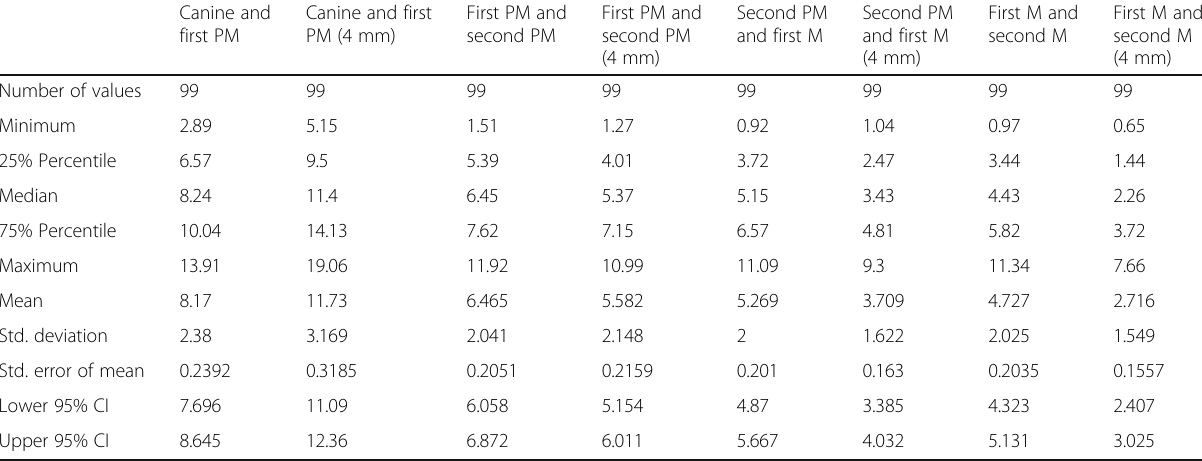
Table 1 Descriptive statistics of palatal bone thickness in growing male